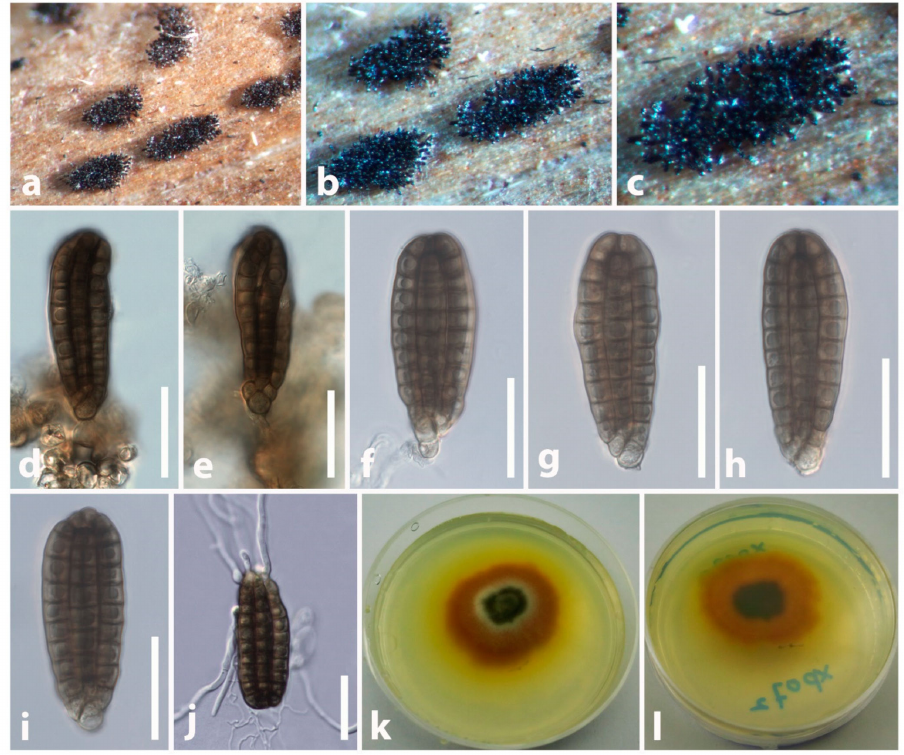
Figure 2. Dictyocheirospora acaciae (CMUB 39980, holotype ). ( a , b ) Sporodochia on dead stem of Acacia dealbata . ( c ) Close-up of sporodochium. ( d , e ) Conidiogenous cells with developing conidia. ( f – i ) Conidia. ( j ) A germinating conidium. ( k ) Colonies from above (on PDA/4 weeks). ( l ) Colonies from below (on PDA/4 weeks). Scale bars: ( d – j ) = 25 µ m. Saprobic on the decaying stem of Acacia dealbata Link (Fabaceae). Sexual morph : Unde- termined. Asexual morph : Hyphomycetous. Colonies 170–300 µ m in diameter ( x = 250 µ